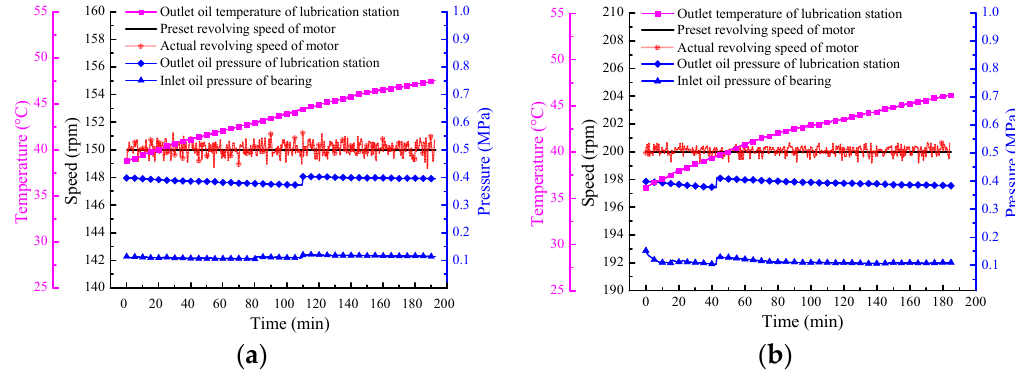
Figure 3. Systematic properties of an oil ‐ film bearing test rig. ( a ) 150 rpm ‐ 12 MPa; ( b ) 200 rpm ‐ 6 MPa. In order to guarantee oil to flow into bearings, initial oil pressure must be set within a proper range. Pressure transducers and a self ‐ operated pressure regulator installed on the oil pipeline near the entrance to bearings are used to monitor and regulate inlet oil pressure of bearings. As shown in